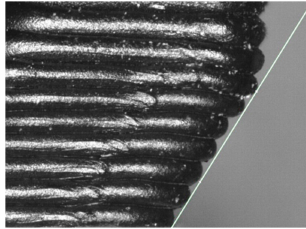
Figure 11. Magnified image of the side profile with a tangent line, to highlight the stair-stepping in the shape of the conductive